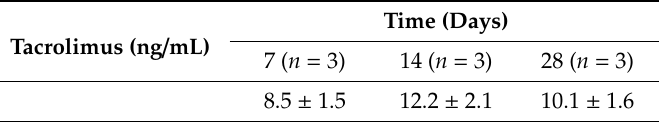
Table 4. Whole blood concentrations of tacrolimus: In vivo drug release results from mixed hydrogels containing 10 mg/mL tacrolimus.